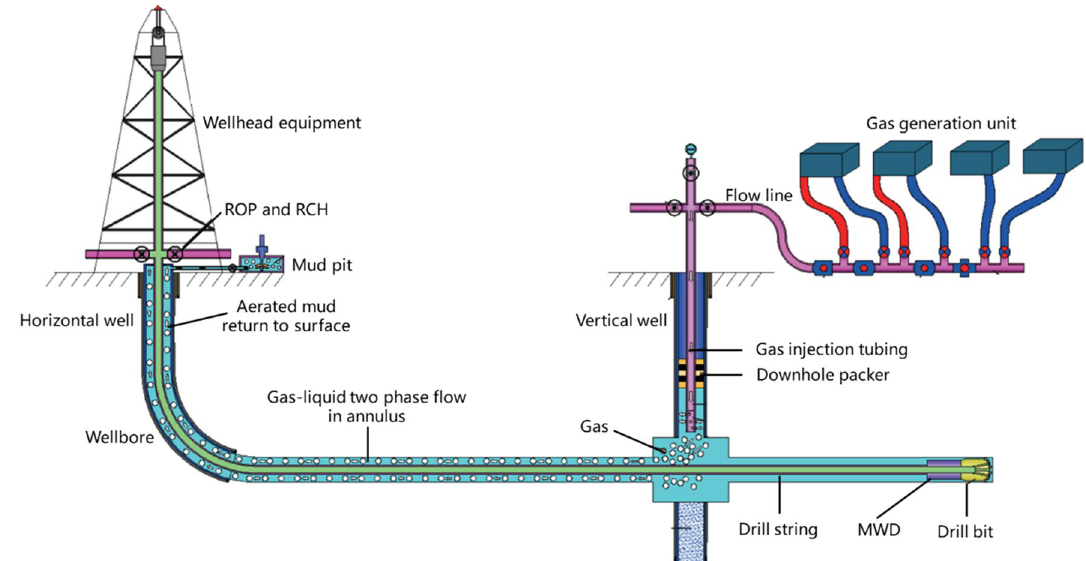
Fig. 24 Schematic of aerated UBD pattern of CBM horizontal well, modified from Gao et al.